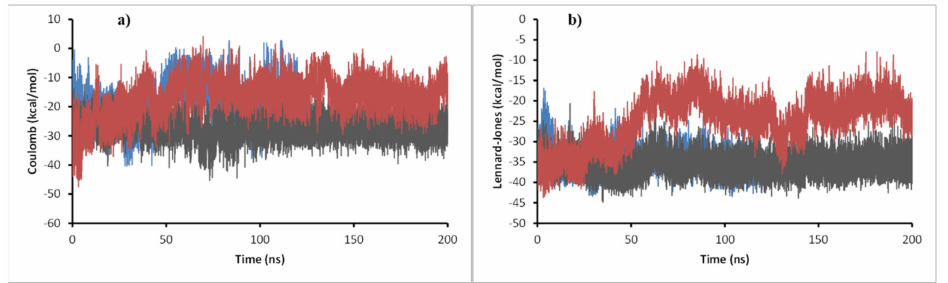
Figure 13. ( a ) Coulomb energy plot and ( b ) Lennard-Jones short-range energies of 11c (blue), 11d (gray), and 11e (red) in complex with DprE1 during the 200 ns of simulation.